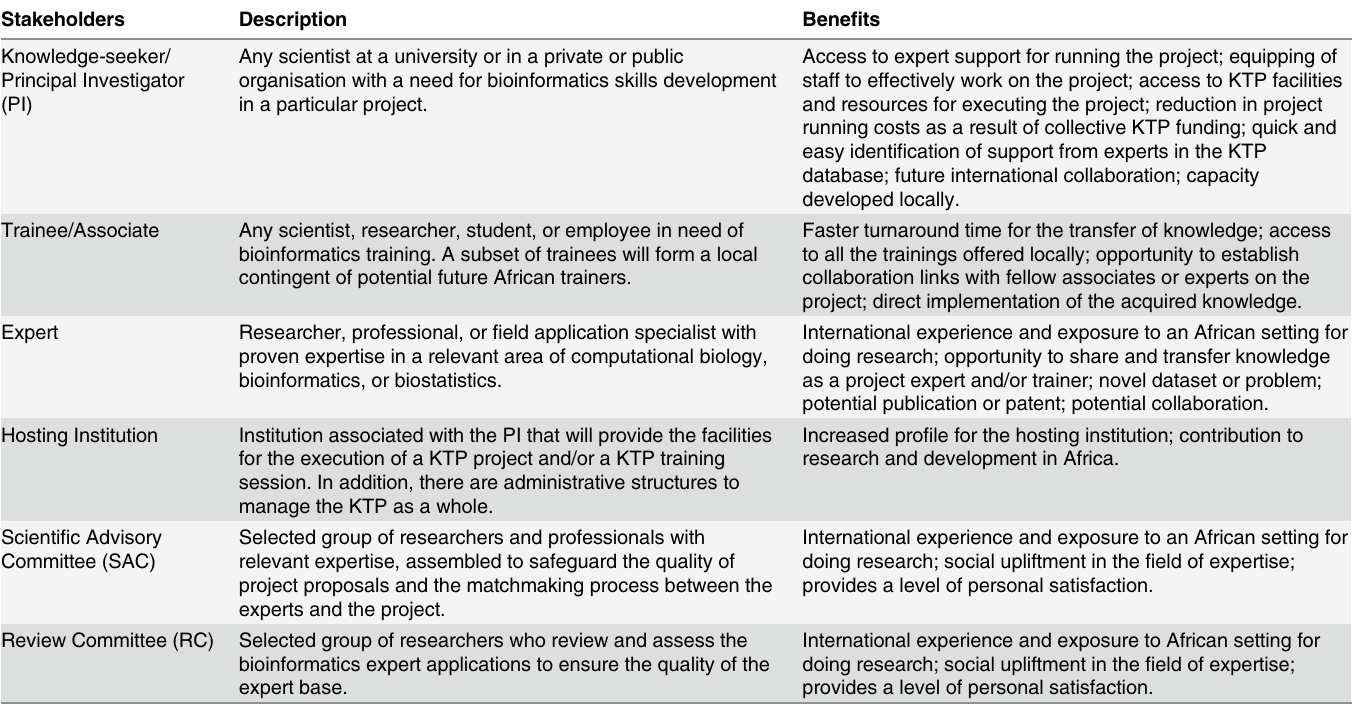
Table 1. Description of the KTP ’ s stakeholders and benefits offered by the KTP to each of the